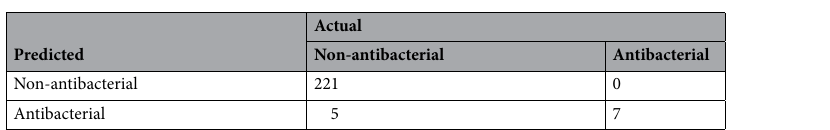
Table 2. Confusion matrix of our final model. This confusion matrix is based on testing set of our final model, molecules with prediction score above 0.5 were regarded as predicted antibacterials.